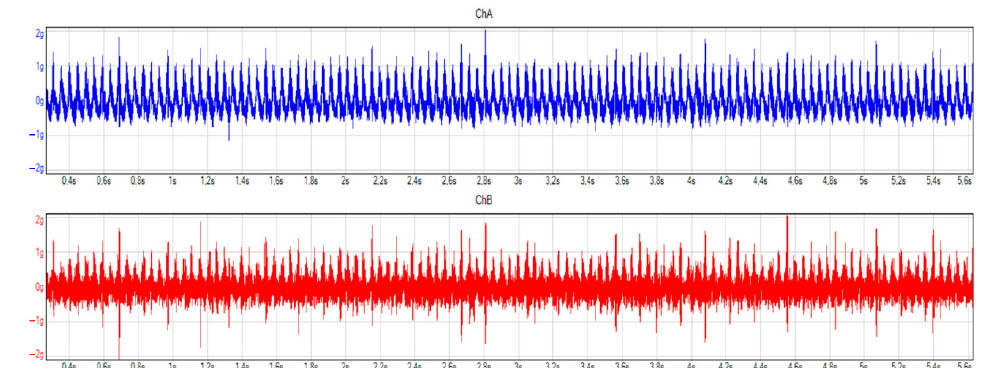
Figure 15. Vibrations in time domain before oil change, standstill, “D” selected. Blue and red colors mean the different considered and applied channels, during the measurement.